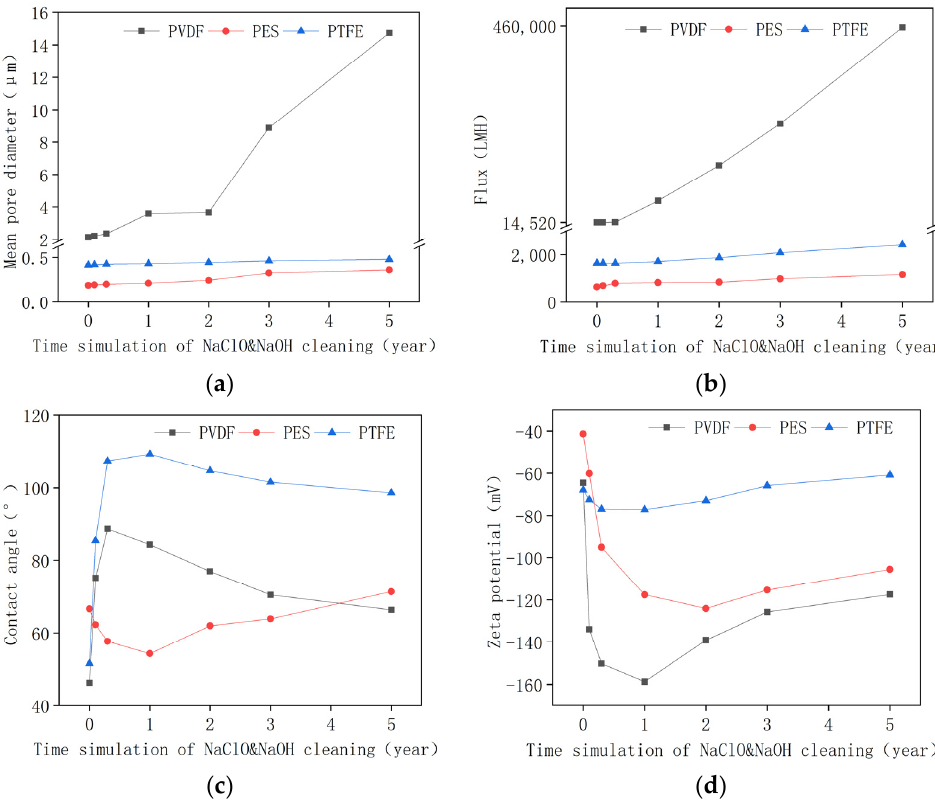
Figure 5. ( a ) Pore size, ( b ) pure water flux, ( c ) contact angle, and ( d ) zeta potential of the pristine membrane and aged membrane in the alkaline oxide aging test.